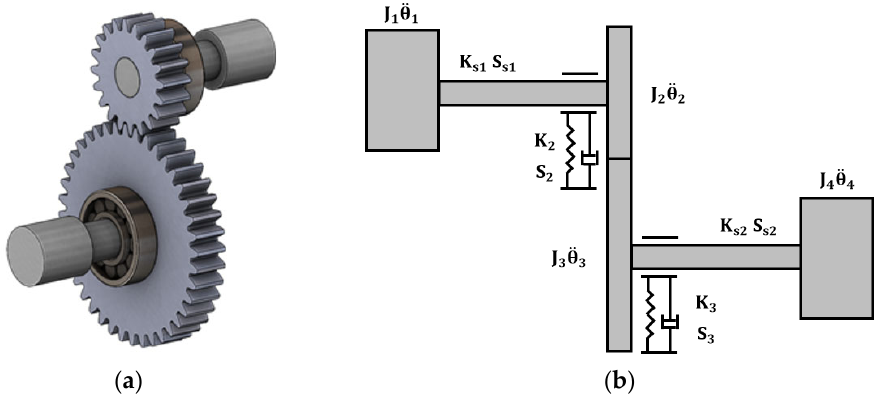
Figure 3. A depiction of the developed 6-DOF dynamic model of a one-stage spur gear transmission: ( a ) physical model; ( b ) schematic diagram.